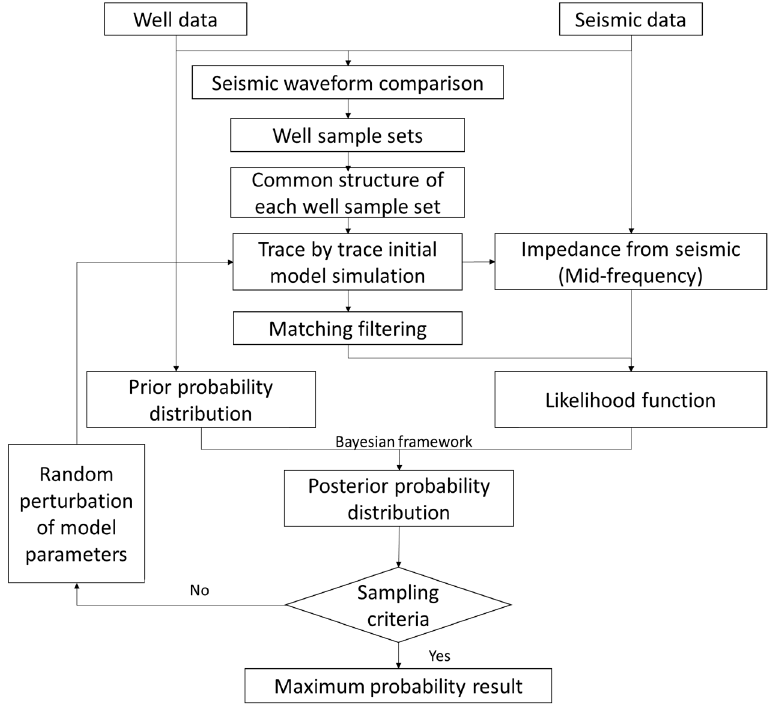
Figure 3. The workflow of seismic waveform indicator inversion.